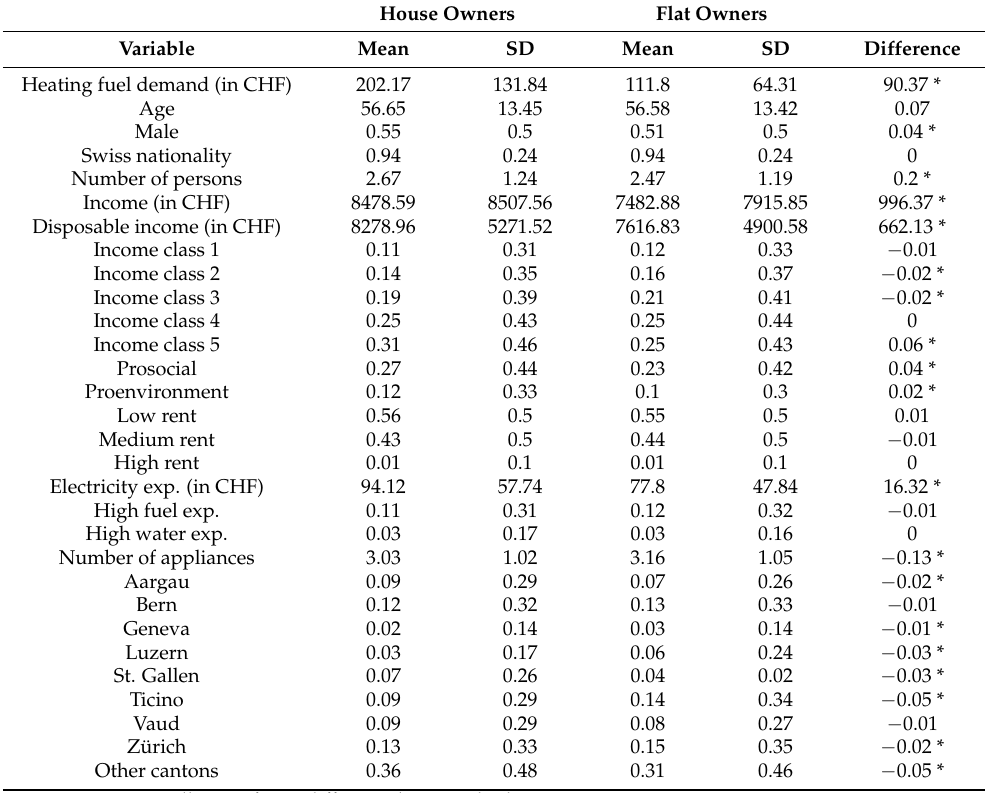
Table A2. Descriptive